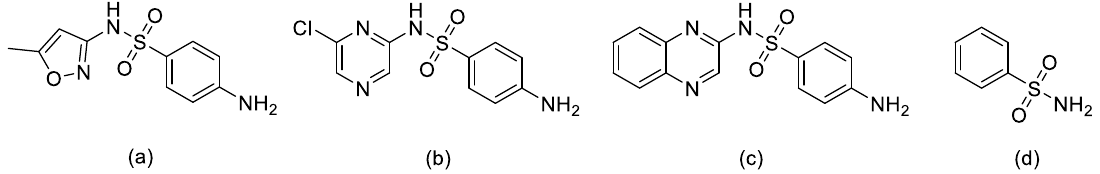
Figure 4. Chemical structures of standards ( a ) sulfamethoxazole, ( b ) sulfaclozine, ( c ) sulfaquinoxaline, and ( d ) benzenesulfonamide.